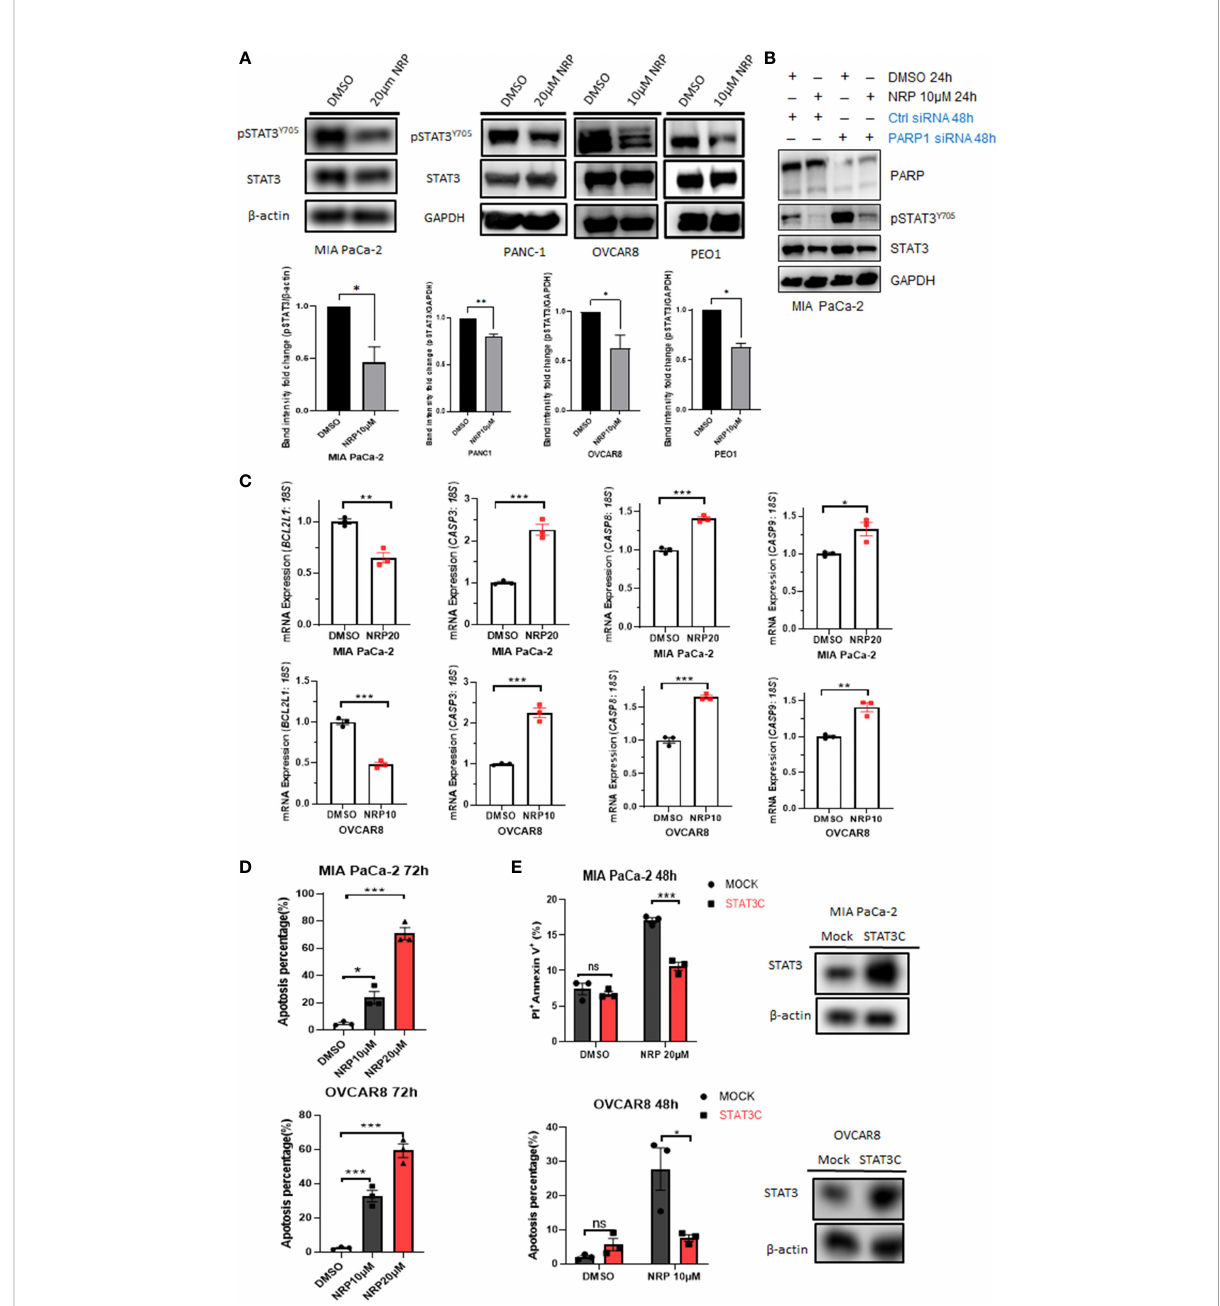
FIGURE 2 NRP inhibits pSTAT3 and enhances cell apoptosis by regulating STAT3 downstream genes. (A) Western blot indicating levels of pSTAT3(Y-705) in MIA PaCa-2, PANC-1, OVCAR8, and PEO1 cells after NRP or DMSO treatment for 24h or 36 hours (PEO1). GAPDH or b -actin served as a loading control. Band intensities from two or three independent experiments were quanti fi ed by ImageJ and showed in a bar graph as mean ± SEM (B) Western blot indicating the level of pSTAT3(Y-705) in MIA PaCa-2 cells transfected with PARP1 siRNA for 2 days, followed by 24-hour NRP treatment. (C) Real-time PCR to examine changes of STAT3 downstream gene expression levels in MIA PaCa-2 and OVCAR8 cells with or without NRP treatment. Gene expression was normalized to the housekeeping gene 18S . Unpaired two-tailed Student t-test. The data shown are as mean ± SEM (N=3). *p<0.05, **p<0.001, ***p<0.0001. (D) NRP-induced apoptosis in MIA PaCa-2 and OVCAR8 cells was examined by Annexin V/PI staining and analyzed by fl ow cytometry 72h after indicated treatments. Unpaired two-tailed Student t-test. Data are shown as mean ± SEM (N=3). *p<0.05, ***p<0.0001. (E) STAT3C overexpression signi fi cantly rescued NRP-induced apoptosis. Mock vector or STAT3C- overexpressing MIA PaCa-2 or OVCAR8 cells were treated with NRP for 48h, followed by Annexin V-APC/PI and fl ow cytometry. Unpaired two- tailed Student t-test. Data are shown as mean ± SEM (N=3). ns, not signi fi cant. *p<0.05, ***p<0.0001. Total STAT3 levels in STAT3C- overexpressing cells were examined by Western blot. b -actin served as a loading